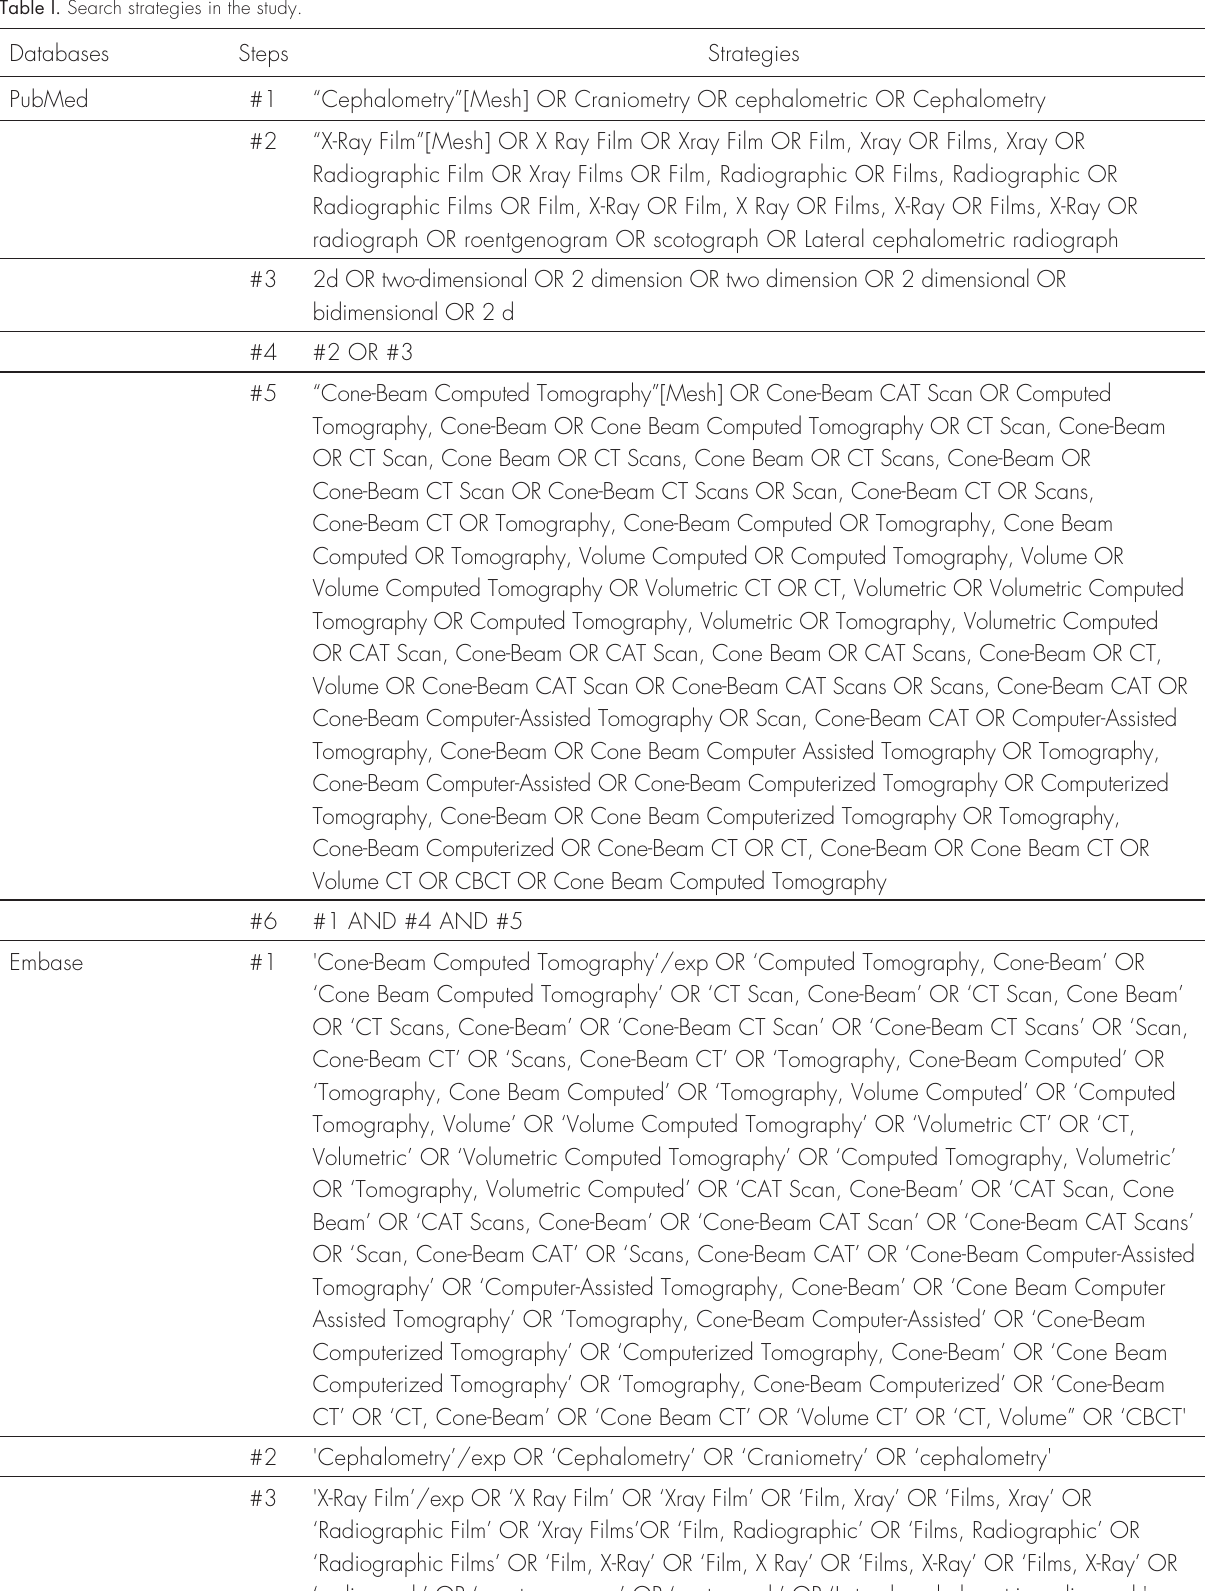
Table I. Search strategies in the study. Databases Steps Strategies